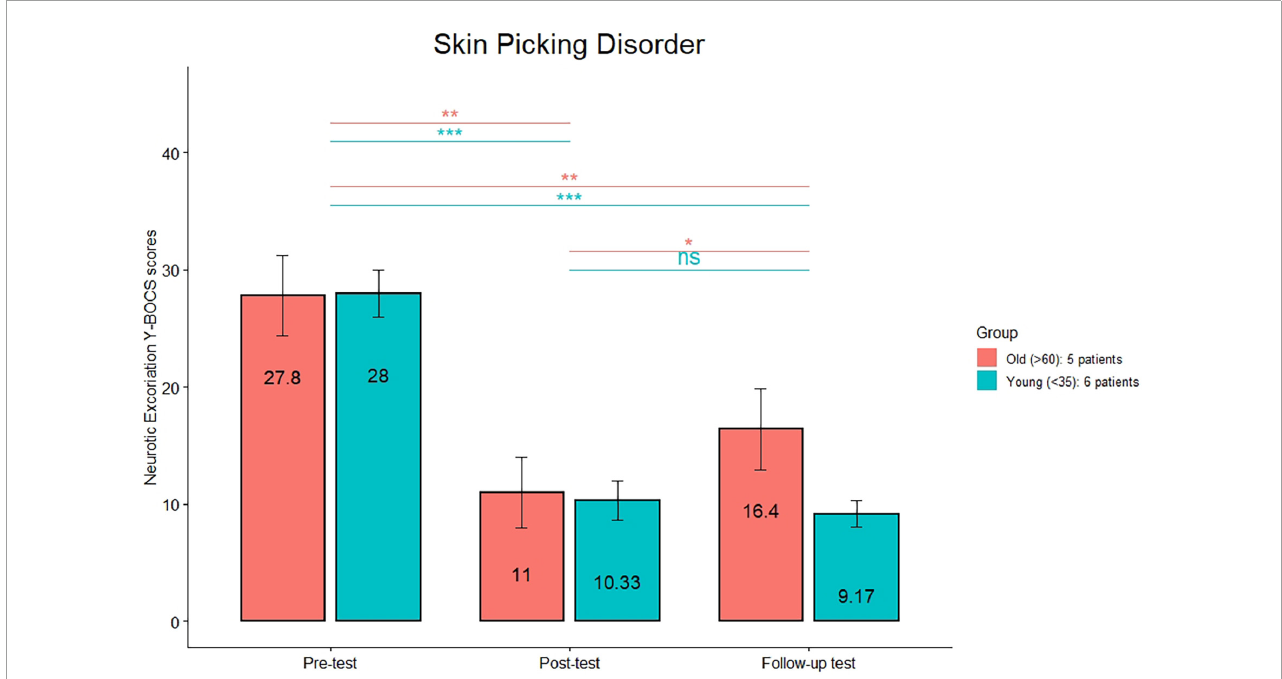
FIGURE3 Neurotic Excoriations Yale-Brown Obsessive-Compulsive Scale mean scores are reported for the young and old subgroups in the trichotillomania group at the three timepoints (pre-treatment, post-treatment, and 1 month follow-up). *** p < 0.0001; ** p < 0.01; * p < 0.05; n.s.: not